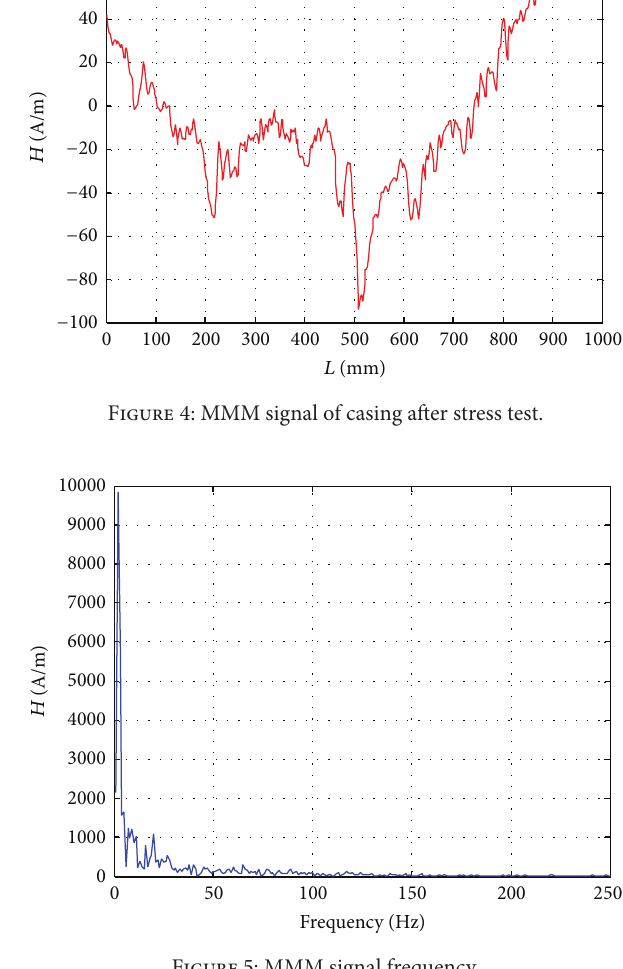
Figure 5: MMM signal frequency.